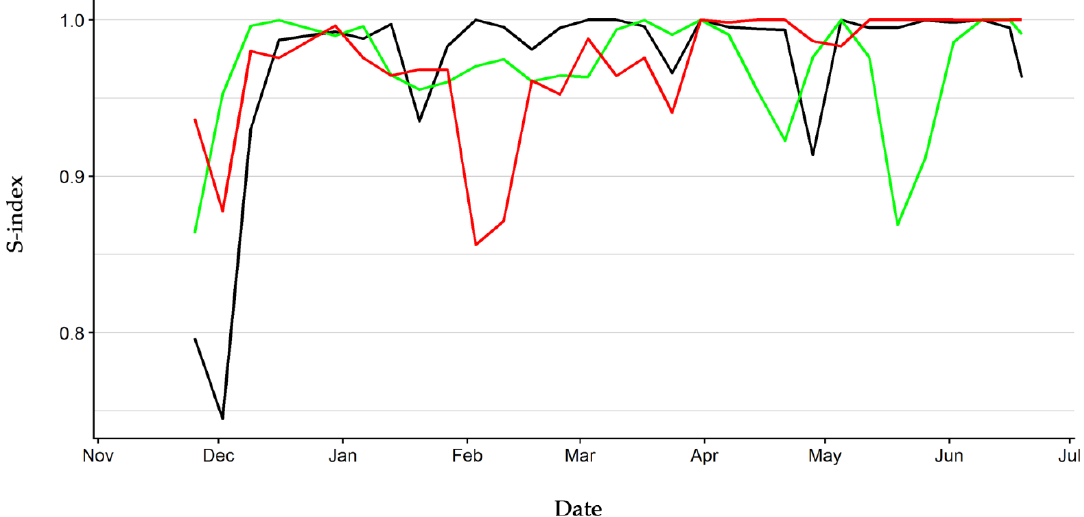
Figure 3. Hierarchy stability index of the three groups of hatchling European pond turtles. Black line: Group one. Green line: Group two. Red line: Group three.